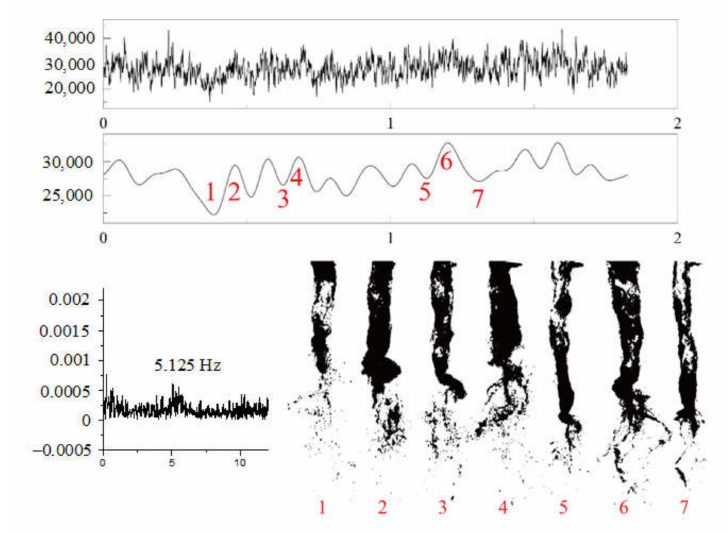
Figure 12. Pressure fluctuation and flow pattern for operating condition A.